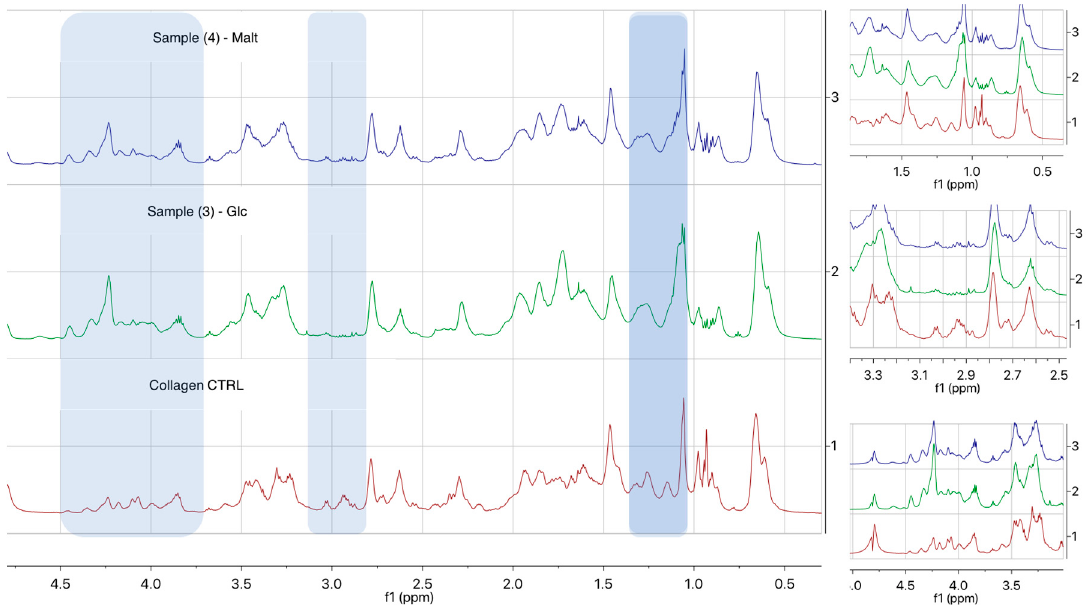
Figure 3. H 1 NMR spectra of collagen samples.